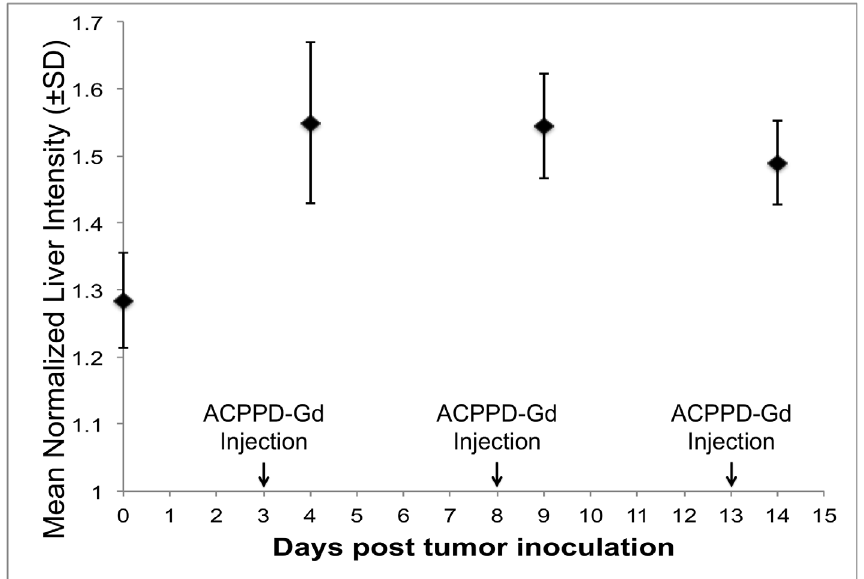
Fig 5. Effect of cumulative ACPPD-Gd injections on Liver Enhancement. Mean liver enhancement ± SD as measured on T1w coronal scans normalized to muscle just prior to tumor inoculation and before any ACPPD-Gd administration (day 0) and 24 hours following ACPPD-Gd on days 4, 9, and 14. Note that liver enhancement of approximately 25% greater than baseline liver signal remained similar after each